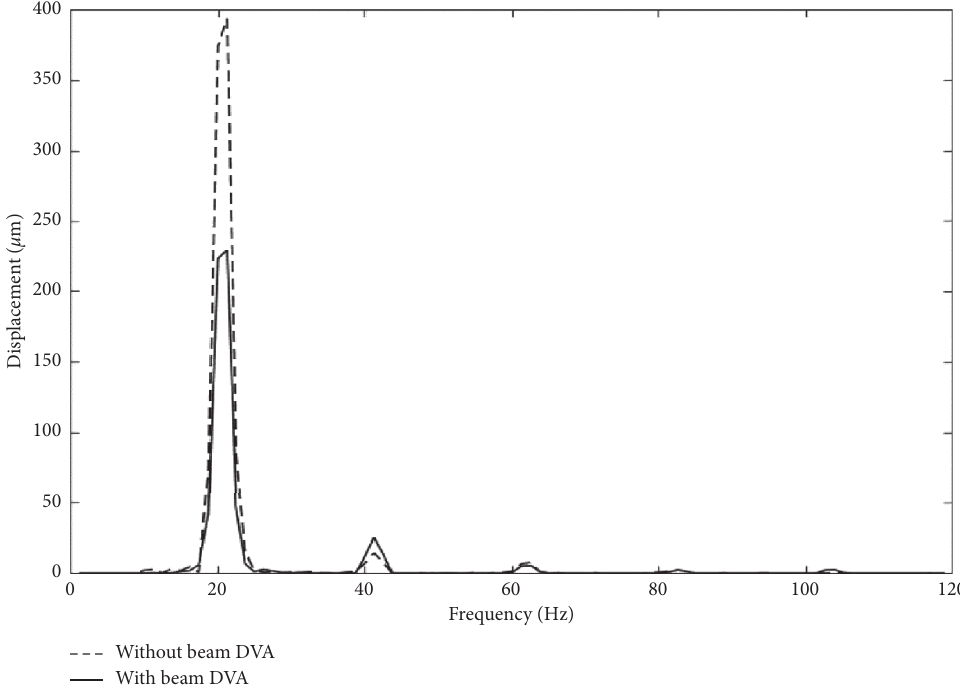
Figure 14: Experimental results of the 3-inch pipeline structure with the inverter operating at around